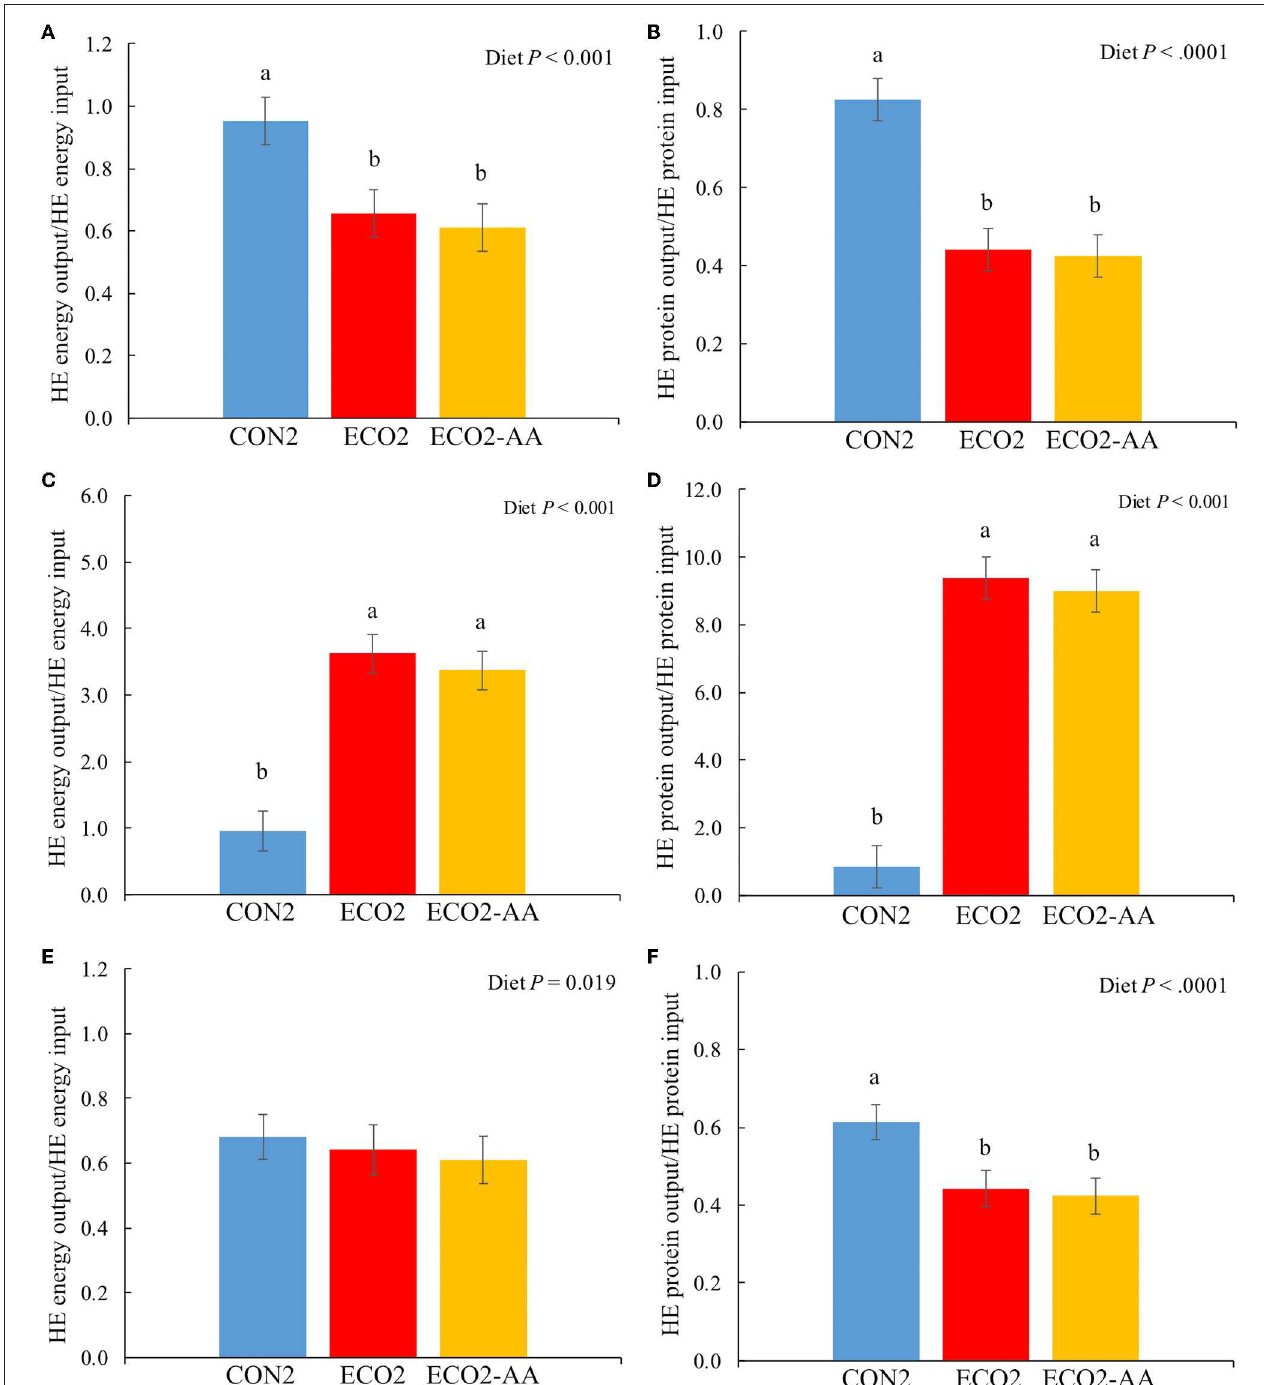
FIGURE 2 | Human-edible (HE) metabolizable energy (top panels) and protein (bottom panels) conversion rate of mid-lactation cows fed a conventional lactation diet or a co-product-based diet (Experiment 2) in a thrift scenario (A,B) , in a choice scenario (C,D) , or in a land use scenario (E,F) , where a recovery value of 2 would indicate that for every HE unit (either MJ ME or protein) the cow consumes, she would produce 2 HE unit in milk. Thrift scenario considered that hominy feed and wheat middlings were edible by humans, whereas choice scenario considered that hominy feed and wheat middlings were not edible by humans. Land use scenario calculations were made based on thrift scenario with additional consideration that the land used for alfalfa production could be used to grow corn and soybeans for direct human consumption. Conventional lactation TMR (CON2), co-product feeds; TMR composed of ecological leftover feedstuff (ECO2); and ECO2 with top-dressed rumen-protected amino acids [ECO2-AA; 77 g/d AjiPro-L (Ajinomoto, Chicago, IL) and 45 g/d MetaSmart (Adisseo, Antony, France)]. ME stands for metabolizable energy. Letters above columns describe treatment differences ( P < 0.05; Tukey’s Honestly Significant Difference test). Error bars are SE.